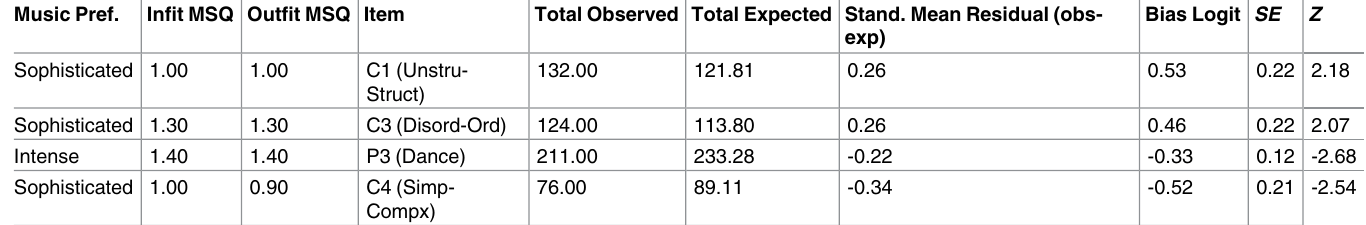
Table 6. Summary of Differential Facet Functioning Statistics (Music PreferenceInteractions) for Item Exhibiting | Z | > = 2.0. Showingonly selected items, which were significantly overrated by listeners with specific musical preferences. Music Pref. Infit MSQ Outfit MSQ Item